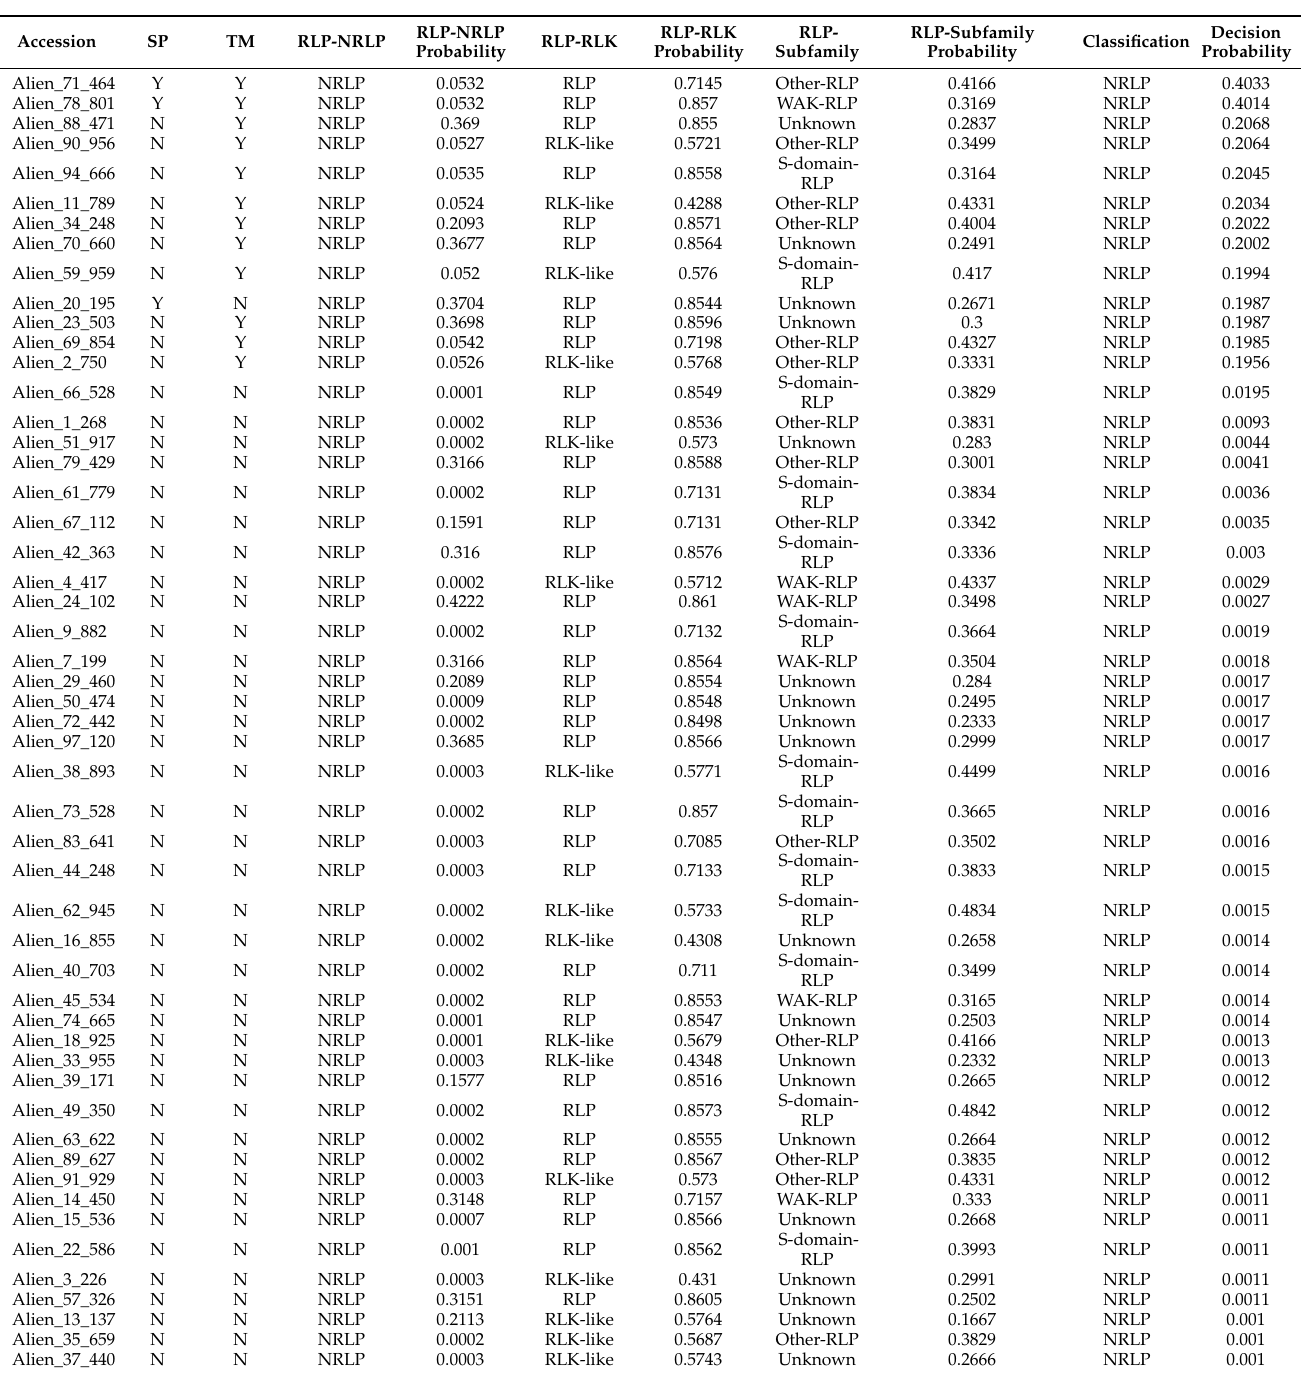
Table 8. Random sequences confronted against